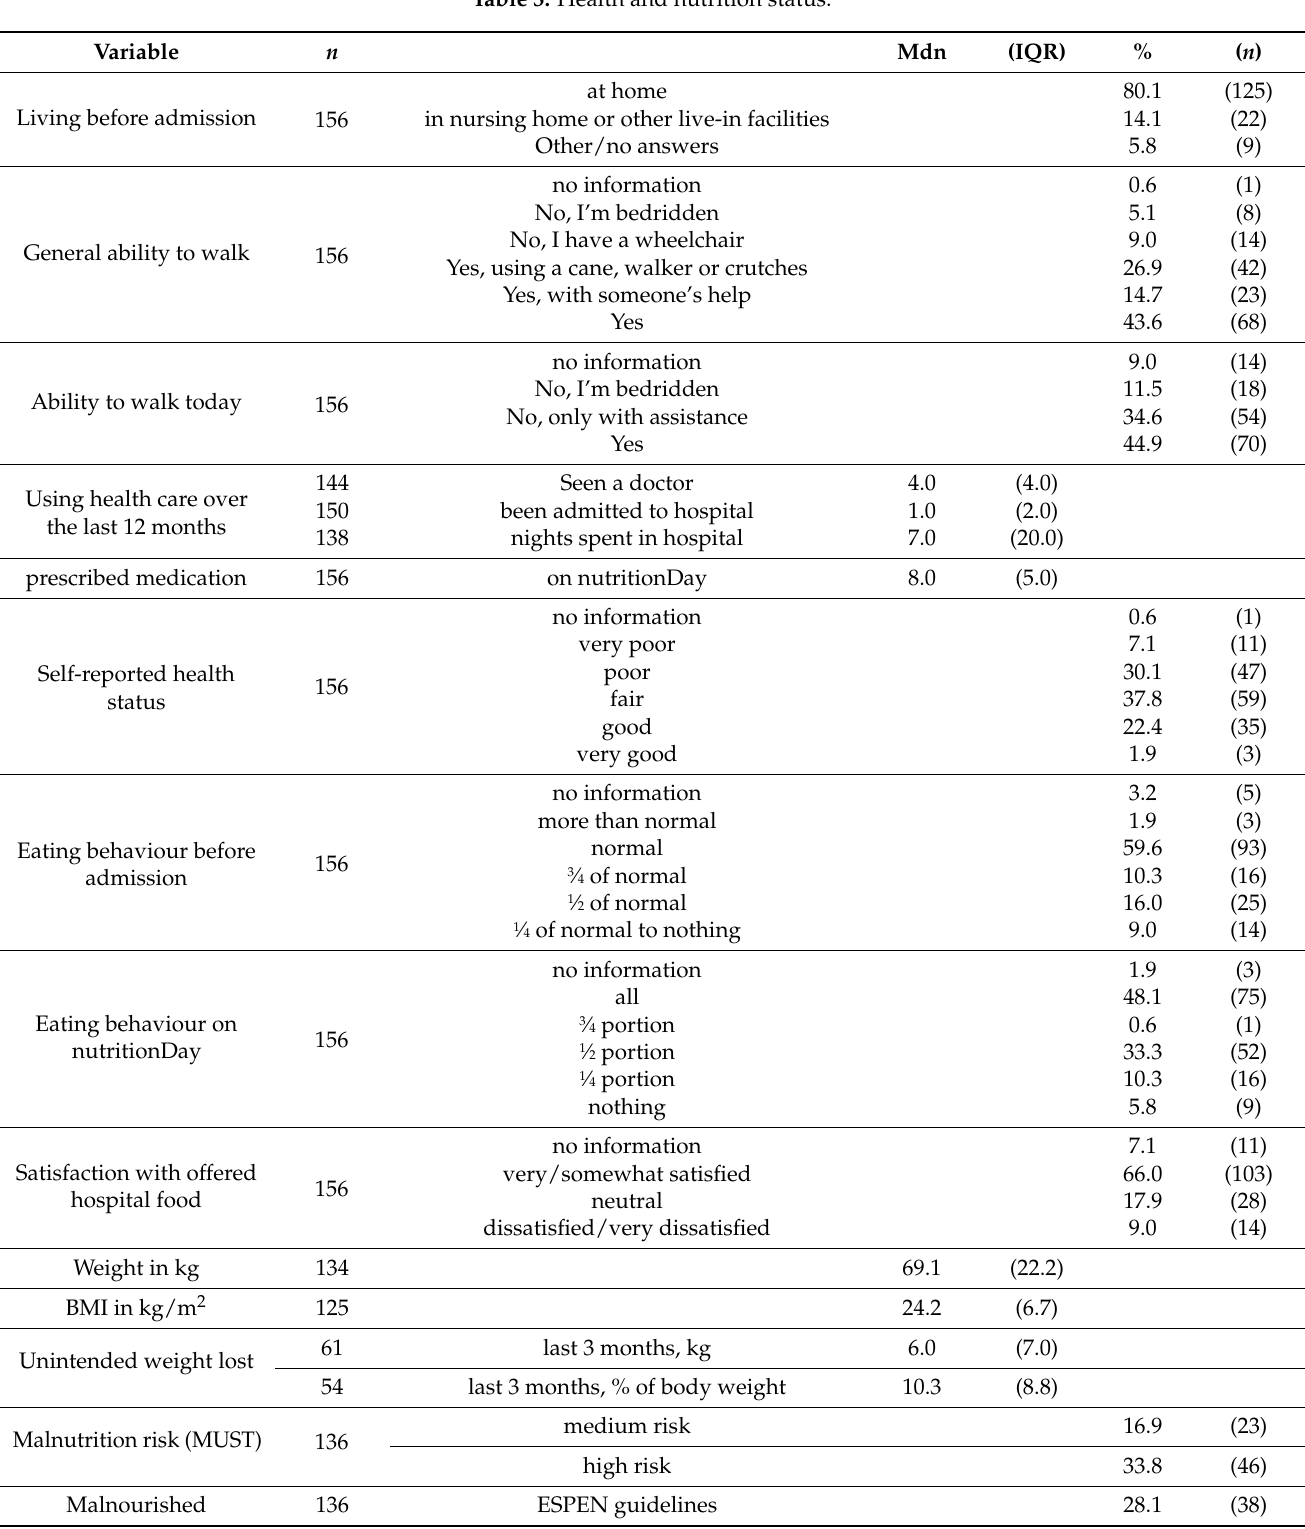
Table 3. Health and nutrition